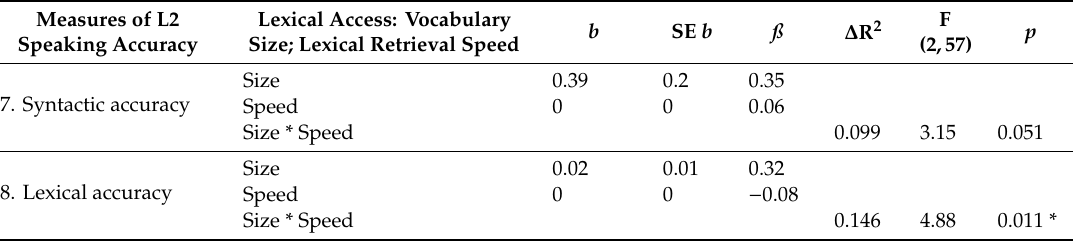
Table 5. Prediction of L2 speaking performance by lexical access.